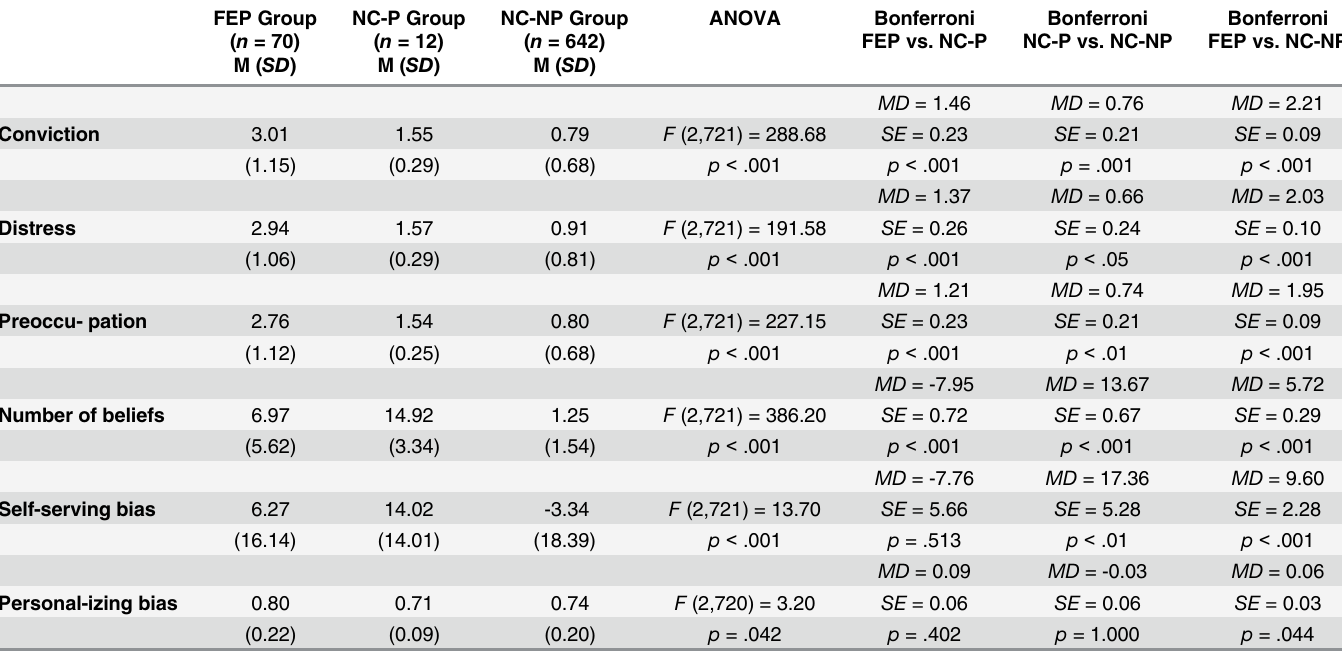
Table 1. Group comparisons of delusional ideation and attributional